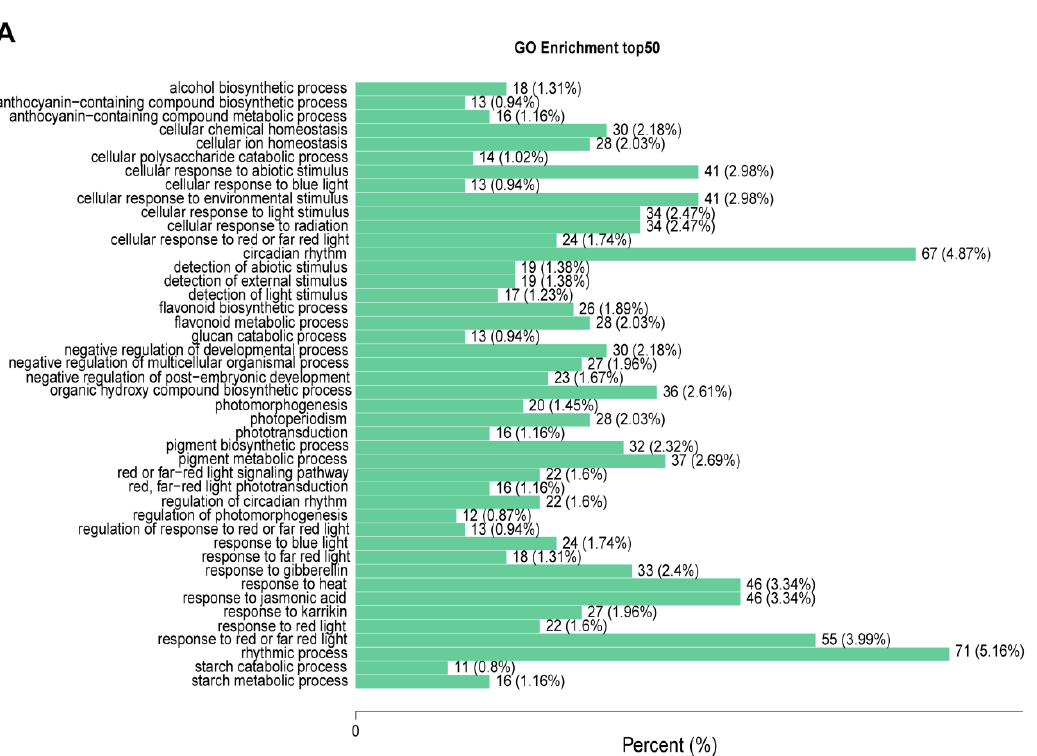
Figure 3. Bioinformatic analysis on differentially expressed genes induced by low light treatments in the petiole of XH1 cai-tai seedlings. ( A ) Top 50 terms based on Gene Ontologies (GO) enrichment analysis. ( B ) Top 20 terms based on Kyoto Encyclopedia of Genes and Genomes (KEGG) analysis. Moreover, we analyzed the expression levels of the known genes related to anthocy- anin biosynthesis pathway in response to low light treatments (Figure 4C and Table S6). Results show that eight DEGs related to anthocyanin biosynthetic pathway were down- regulated under low light condition such as Bra009101, Bra012862, Bra023441, Bra013652, Bra019350, Bra027457, Bra036208 and Bra038445, respectively (Table S6).